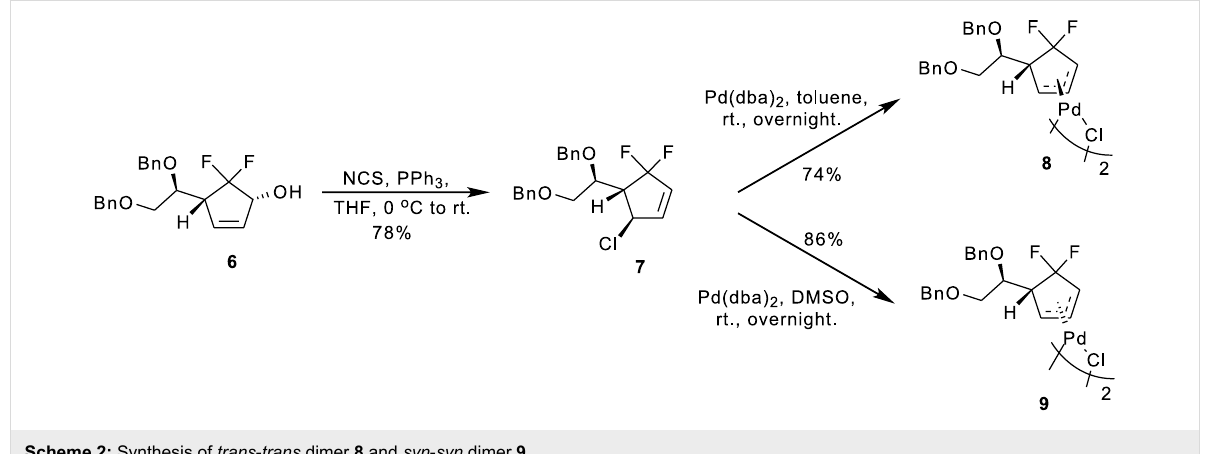
Scheme 2: Synthesis of trans - trans dimer 8 and syn - syn dimer 9 .